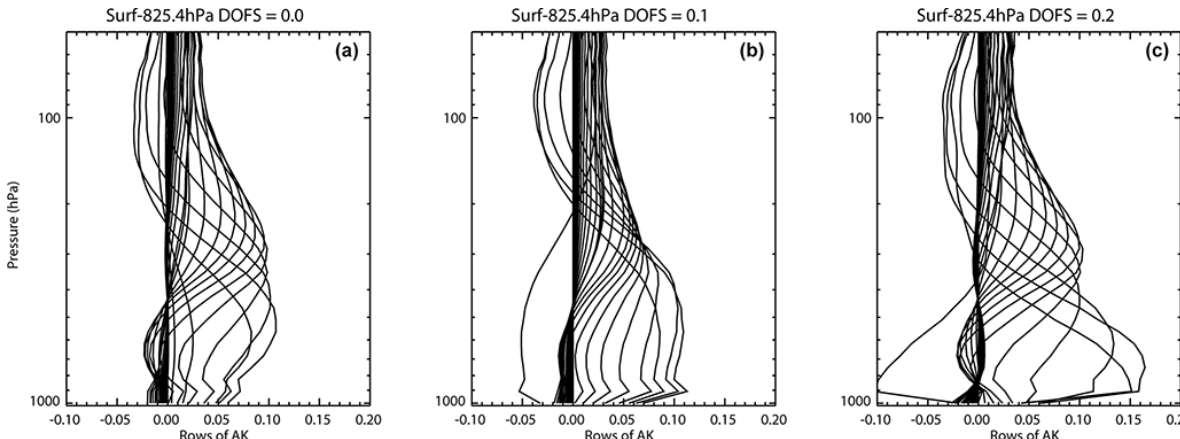
Figure 8. Plots of averaging kernel rows for CH 4 retrievals. The spectral ranges are (from a to c ) LWIR, SWIR, and LWIR + SWIR. These results are for the West Virginia case. Table 8. Estimates of total and precision errors for JPL GEO-IR Sounder, CrIS, and AIRS TATM and H 2 O retrievals in the troposphere. Note that data used for CrIS and AIRS retrievals were obtained near Houston, Texas, in August 2020. Averaged retrieved cloud optical depths are limited to less than 0.1, consistent with mostly clear-sky